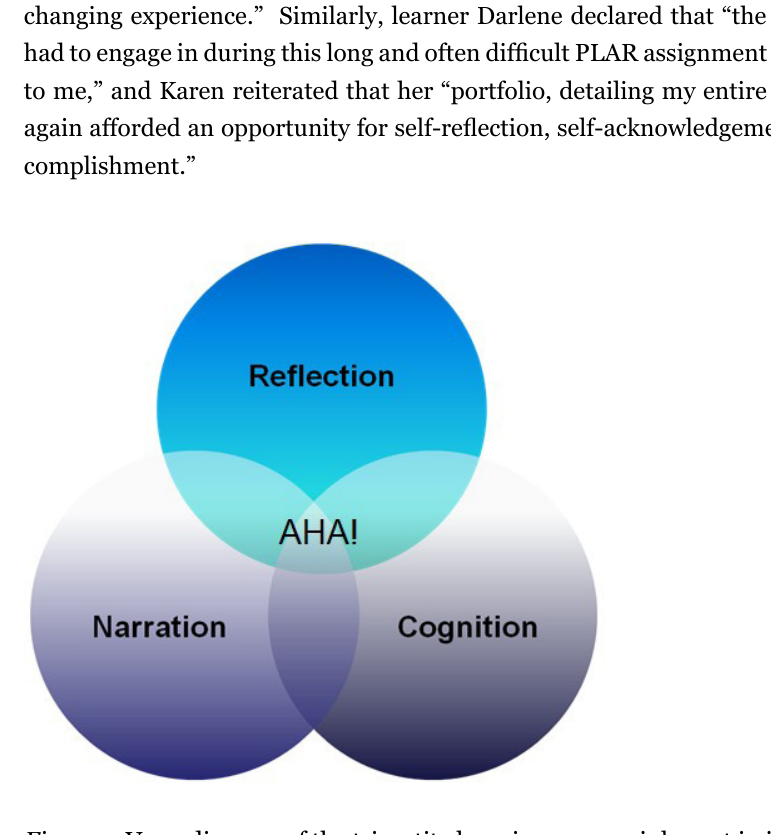
Figure 1 . Venn diagram of the tripartite learning process inherent in institutional portfolio